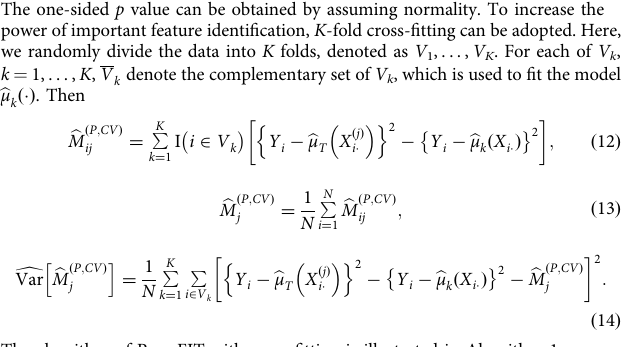
The algorithm of PermFIT with cross- fi tting is illustrated in Algorithm 1.